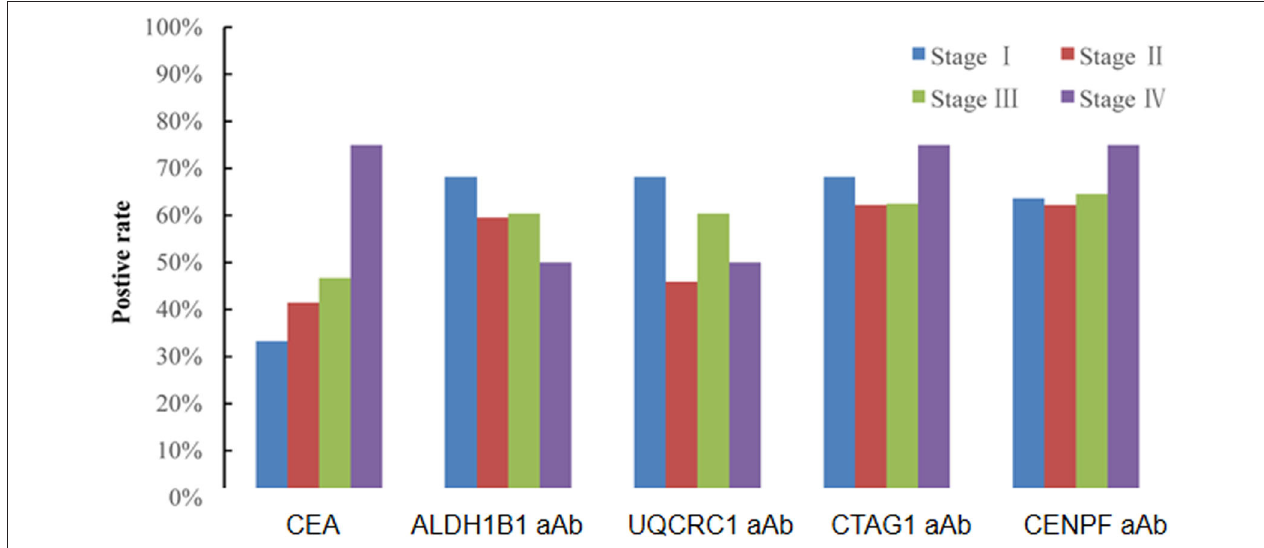
FIGURE 4 | Comparison of the positive rates of CEA and autoantibodies against ALDH1B1, UQCRC1, CTAG1, and CENPF in CRC of different UICC stages.